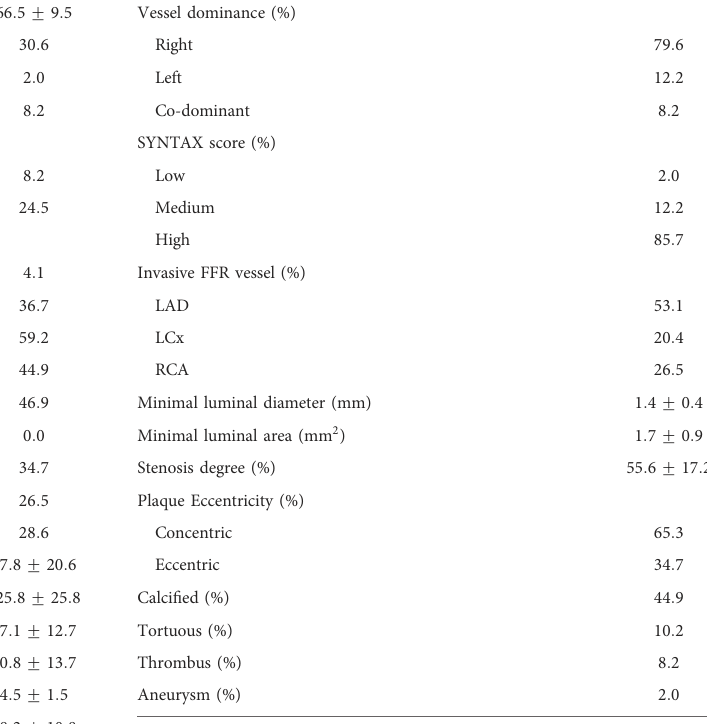
Vessel dominance